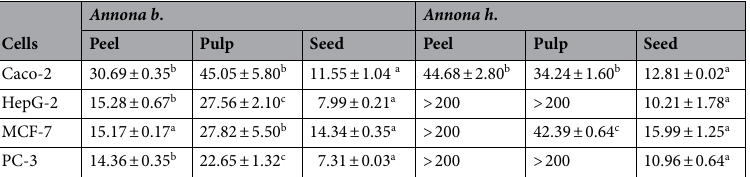
treatment on HepG-2, Caco-2, and MCF-7 cell lines using annexin V/propidium iodide (PI)-flow cytometric analysis (Fig. 4A,B). Results revealed a significant elevation in total apoptosis percentages (> 48%) in the Annona b. seed extract-treated Caco-2, HepG-2, MCF-7, and PC-3 cells in comparison with those treated by Annona h. seed extract (< 39%). The most affected cell lines were PC-3 (51.27 ± 0.1%) and HepG-2 (50.14 ± 0.32%), followed by MCF-7 (49.30 ± 0.07%) and Caco-2 (48.81 ± 0.16%) after Annona b. seed extract treatment. On the other hand, the most affected cell lines were MCF-7 (38.99 ± 0.37%) and Caco-2 (33.05 ± 0.3%) followed by HepG-2 (32.67 ± 0.33%) then PC-3 (29.43 ± 0.035%) after Annona h. seed extract treatment. Natural products are still important sources to discover new anticancer drugs 42 . The National Cancer Insti-